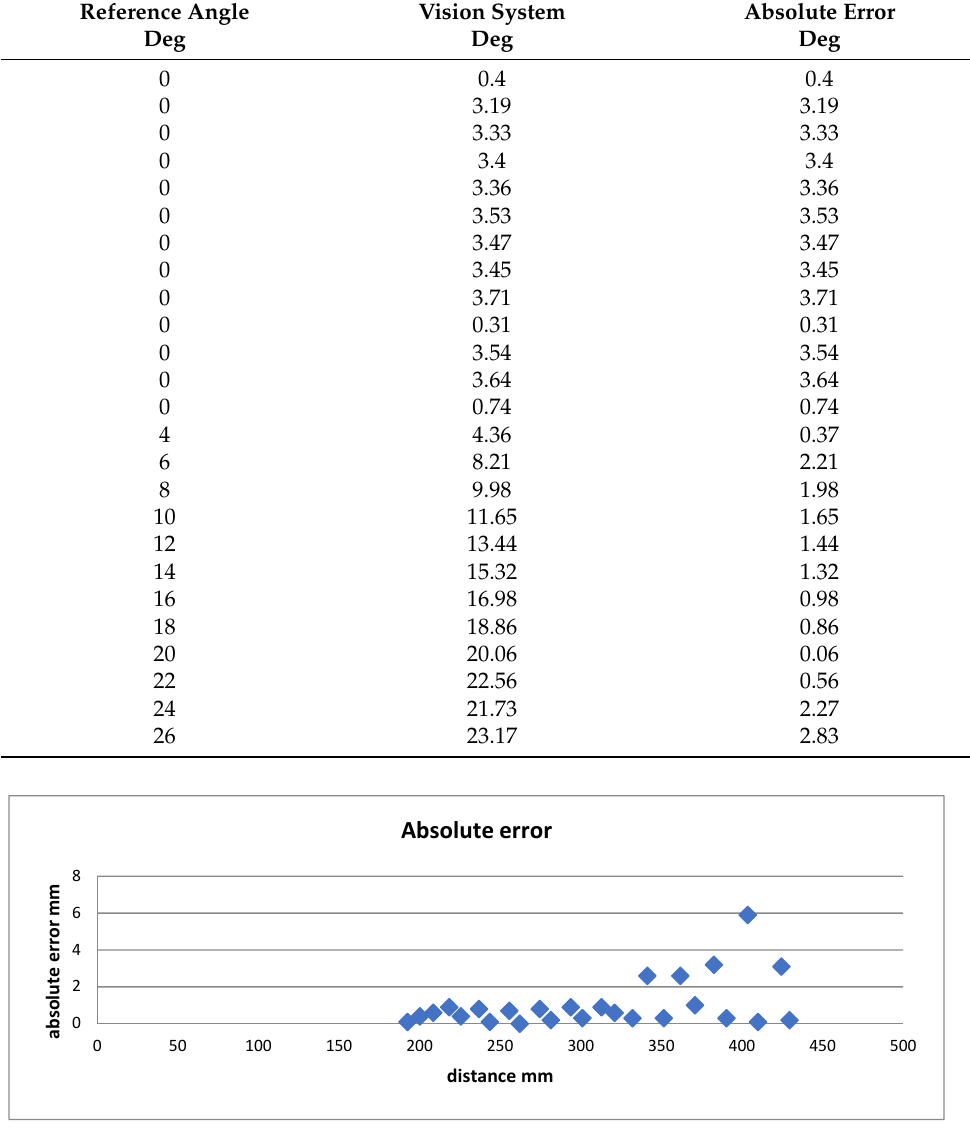
Figure 5. The dependence of the measurement error on the distance from the marker. Table 3. Measurement of rotation around the y -axis by a vision system.